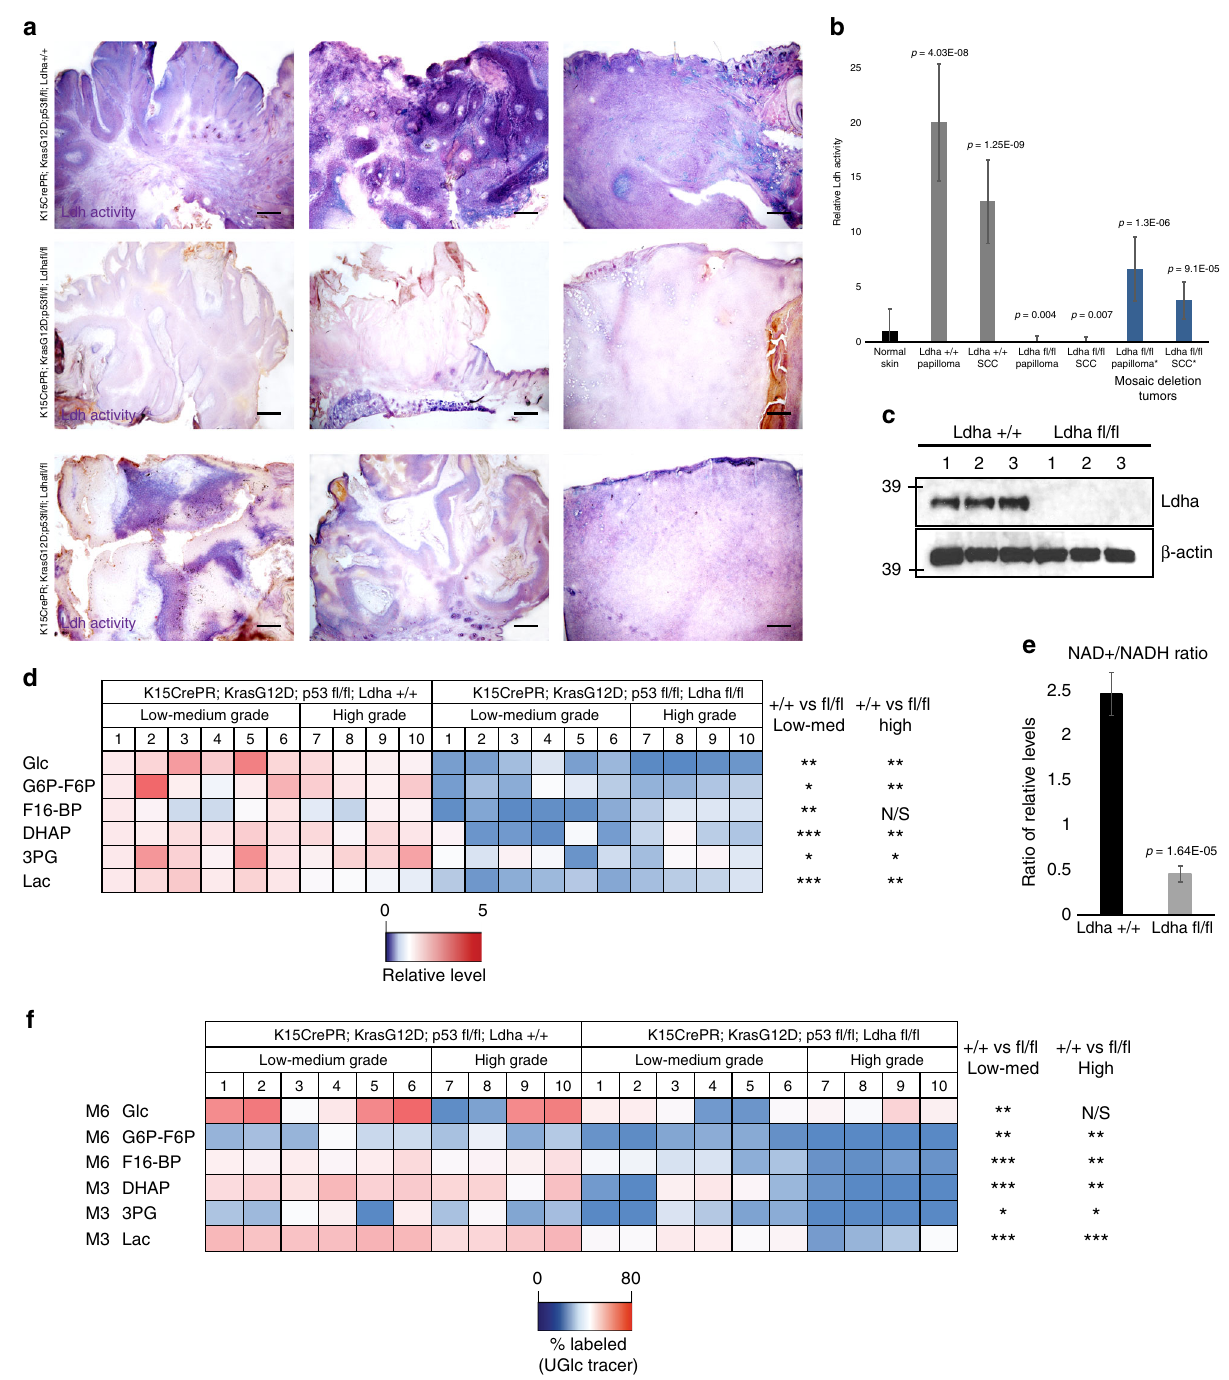
Fig. 3 Metabolic effects of loss of Ldha during tumorigenesis. a In situ measurement of maximal Ldh activity in tumors with and without Ldha deletion shows a dramatic loss of activity in most tumors from the Ldha deletion mice (middle row). Activity is indicated by purple color; pink is a nuclear counterstain. In addition, some tumors formed in deletion mice show mosaicism for Ldh activity, presumably due to mosaic deletion of Ldha mediated by CrePR induced recombination. Scale bars, 200 µ m. b Ldh activity in lysate derived from tumors of the indicated stages. Those samples with * indicated tumors that were deemed to be mosaic for Ldha deletion by the in situ assay. Each bar represents the average signal for each tumor type where n = 6 mice per tumor stage and genotype from 42 animals. Shown as mean ± SEM. Paired t test was performed, P < 0.05 shown for each tumor type versus control skin. c Western blotting for Ldha protein indicated the effectiveness of the genetic deletion. d Heatmap depicts relative levels of glycolytic intermediates as measured by LCMS in tumors from animals with and without Ldha expression. Each column represents metabolite measurements from an individual animal, and 20 animals were used, 10 of each genotype. e NAD + /NADH ratio in Ldha wild-type ( + / + ) vs. Ldha null ( fl / fl ) tumors. Each bar represents the relative NAD + /NADH ratio where n = 10 mice per genotype. Shown as mean ± SEM. Paired t test was performed, P < 0.05 shown for knockout versus wild-type tumors. f Heatmap depicts percentage of glycolytic intermediate isotopomers in tumors with indicated genotypes from animals IP injected with [U- 13 C 6 ] glucose 15 min prior to tumor harvesting. For ( d , f ), ∗ P < 0.05; ∗∗ P < 0.01; ∗∗∗ P < 0.001; NS, P > 0.05. Student ’ s paired t